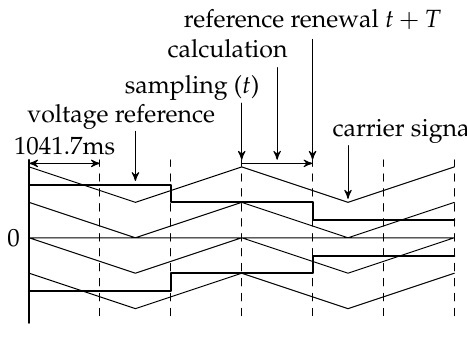
Figure 8. Level shift carrier waveform with sinusoidal reference